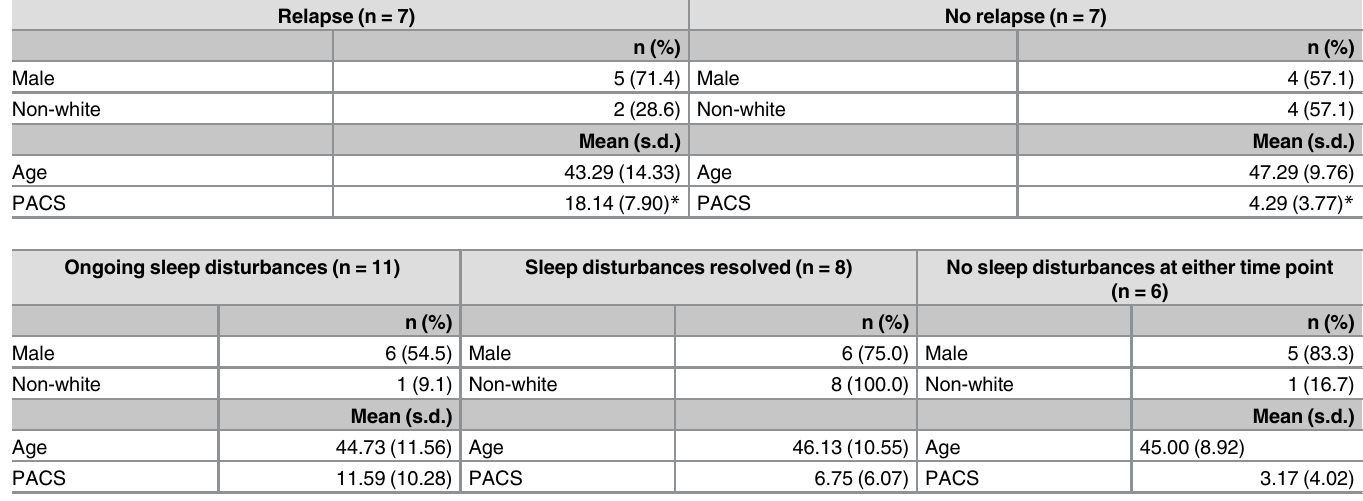
Table 3. Participant demographics and clinical variables by relapse status and sleep